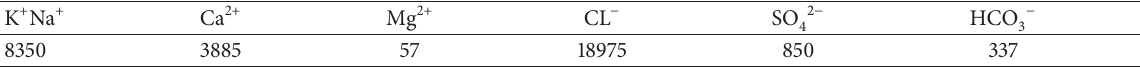
Table 2: Oil field water ions concentration (mg/L).